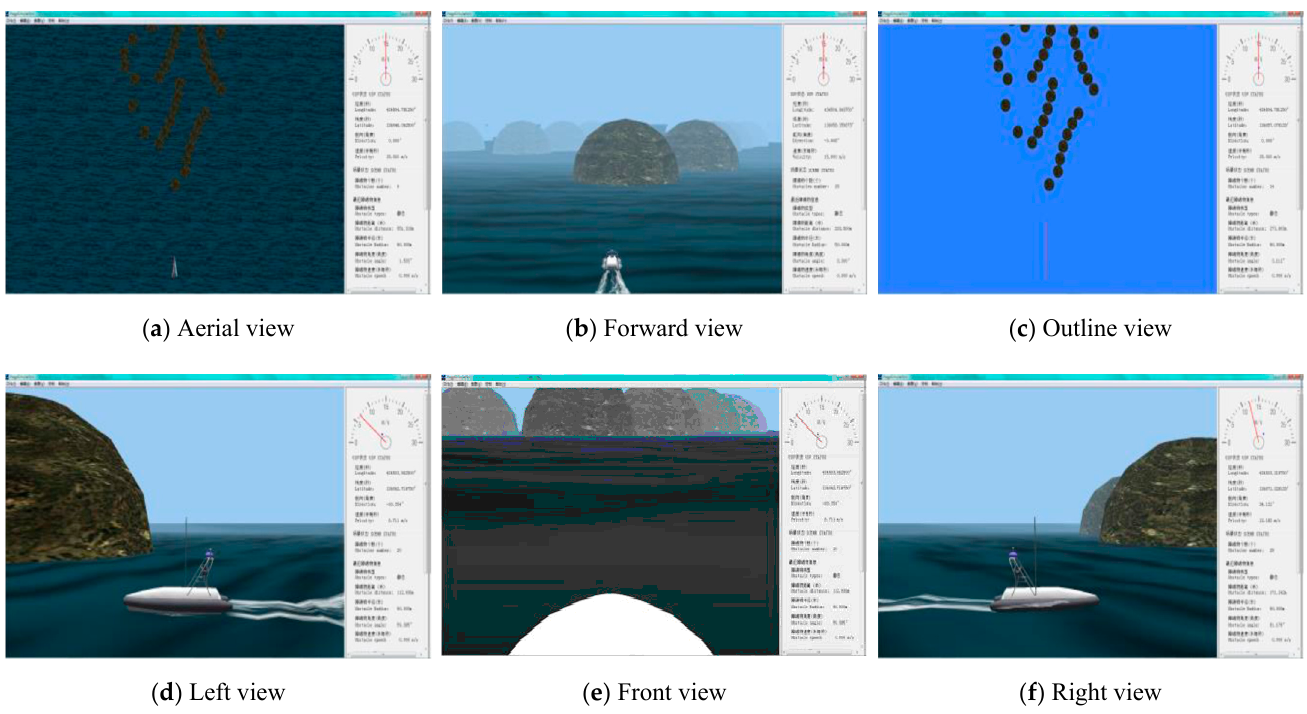
Figure 12. Views of graphic workstation.